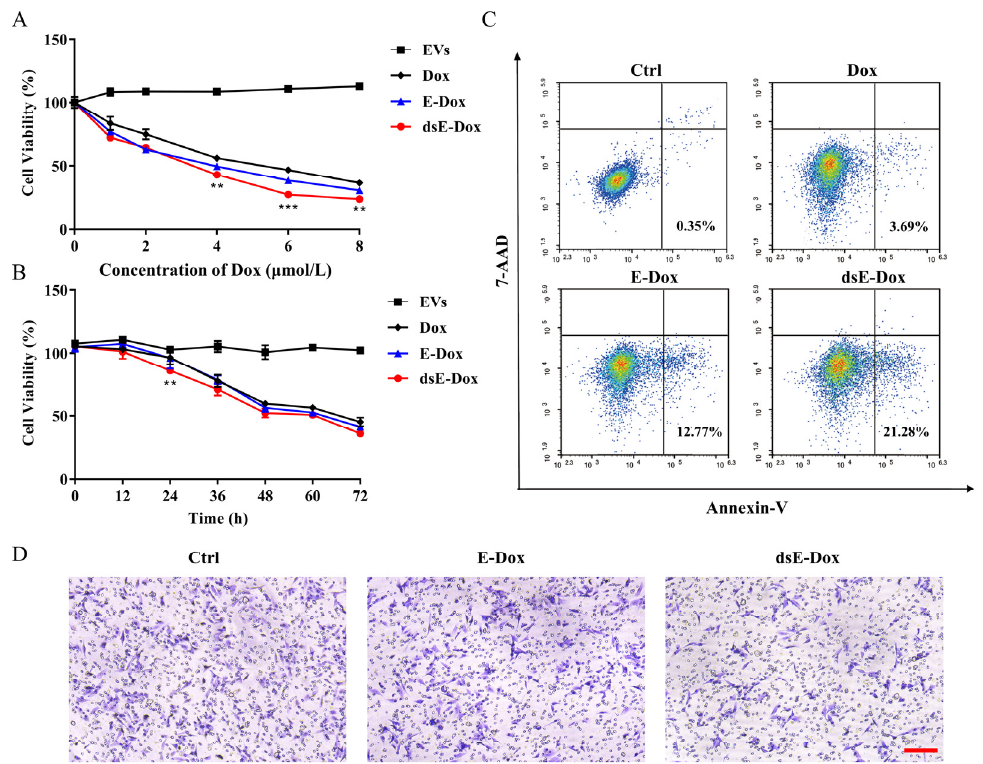
Figure 5. The in vitro antitumor activity of dsE-Dox. ( A ) The viability of HepG2 cells treated with Dox, E-Dox, dsE-Dox (loaded with 0, 2, 4, 6, 8 µ mol/L Dox), or free EVs for 48 h was detected by the CCK-8 assay. ( B ) The effects of Dox, E-Dox, dsE-Dox (loaded with 4 µ mol/L Dox), and free EVs (500 µ g/mL protein concentration) on HepG2 cell viability at different time points were detected by the CCK-8 assay. ( C ) HepG2 cells were treated with PBS, Dox, E-Dox, or dsE-Dox (loaded with 2 µ mol/L Dox) for 24 h and stained with Annexin V-APC/7-AAD. Cell apoptosis was measured by flow cytometry. ( D ) HepG2 cells were treated with PBS, E-Dox, and dsE-Dox (loaded with 2 µ mol/L Dox) for 24 h and the migration ability was detected by the Transwell assay. Scale bar, 150 µ m. The data were presented as the mean values ± SD. ** p < 0.01, *** p < 0.001.